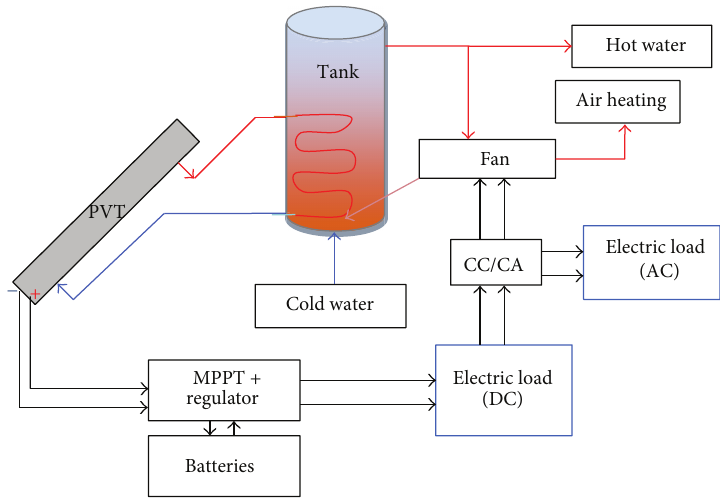
Figure 1: Diagram of the energy system based on the new collector PV/T.